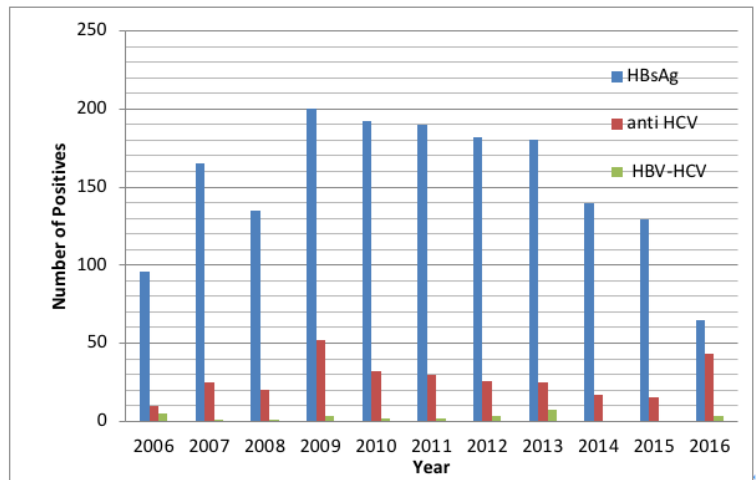
Figure 1. Trends of sero-positivity of HBsAg, anti-HCV, and HBV/HCV co-infection at Bhopal Memorial Hospital and Research Center in Central India 2006 –